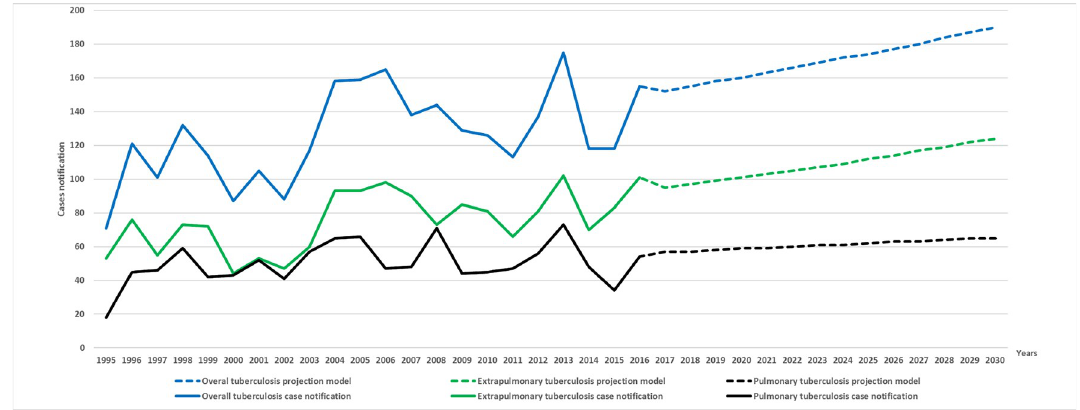
Fig 6. Annual number new cases for the observed (1995–2016) and predicted (2017–2030) periods of total, pulmonary and extra- pulmonary tuberculosis.